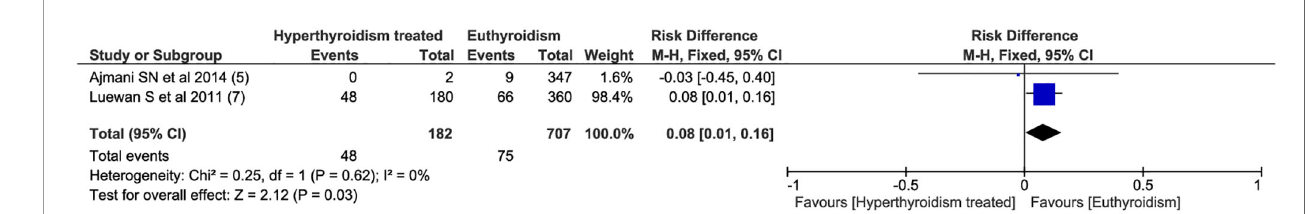
FIGURE 3 | Forest Plot: Low Birth Weight.